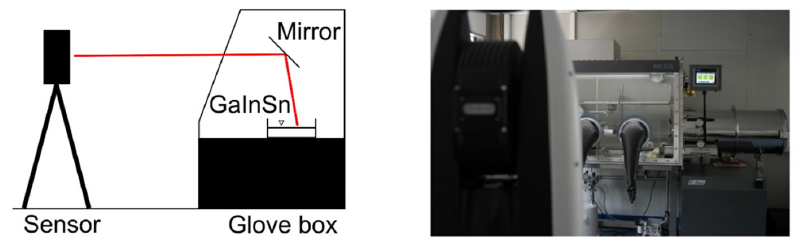
Figure 3. Sketch and picture of the ATS600 measurement setup.